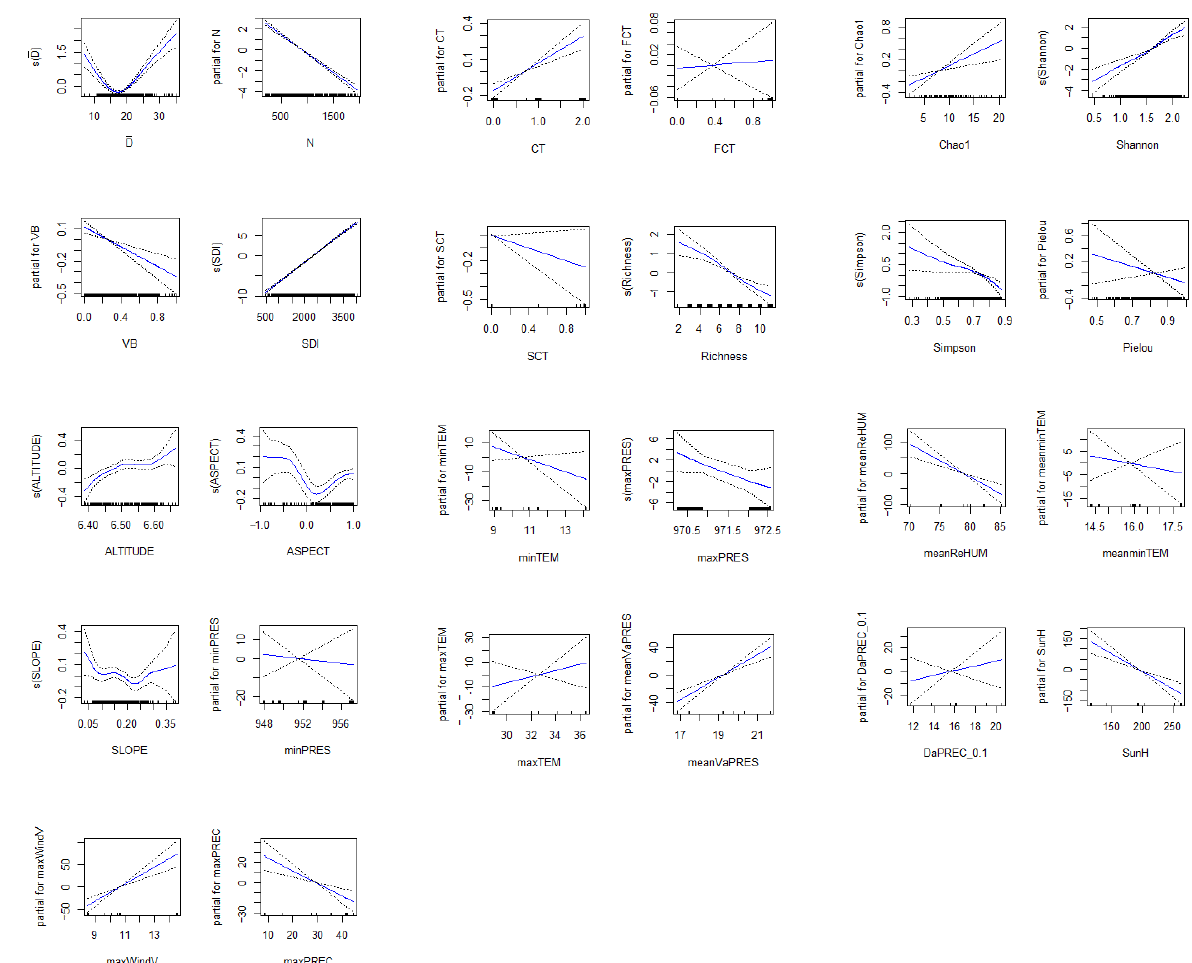
Figure 7. Generalized Additive Model. The local dependence diagram of each influencing factor. The blue line represents the correlation between independent variables and dependent variables, the dotted line indicates the 95% confidence interval.